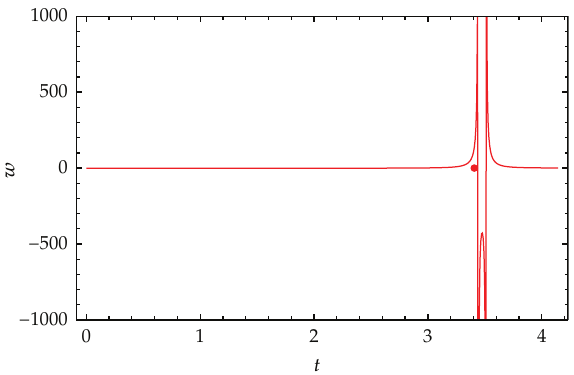
Figure 8: Overview of w φ versus t/t 0 . The dot indicates t ∗ .